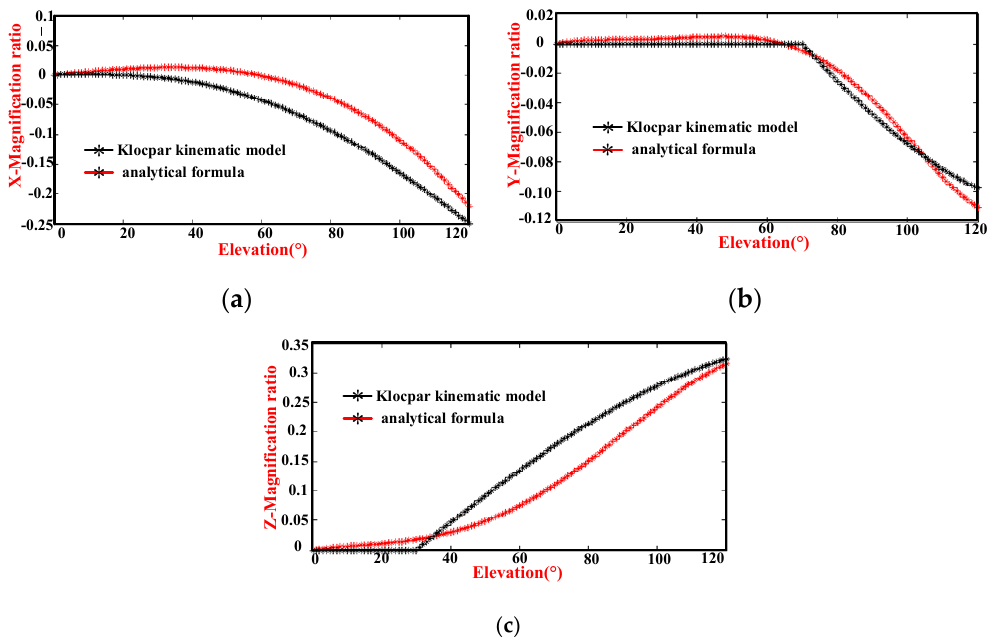
Figure 11. Comparison of the magnification ratio of the GH joint center displacement variable quantity relative to the thorax coordinate system during humeral elevation in the sagittal plane and the Klop č ar kinematic model: ( a ) translational displacement variable quantities x fli and x( Φ ), ( b ) translational displacement variable quantities y fli and y( Φ ), and ( c ) translational displacement variable quantities z fli and z( Φ ).